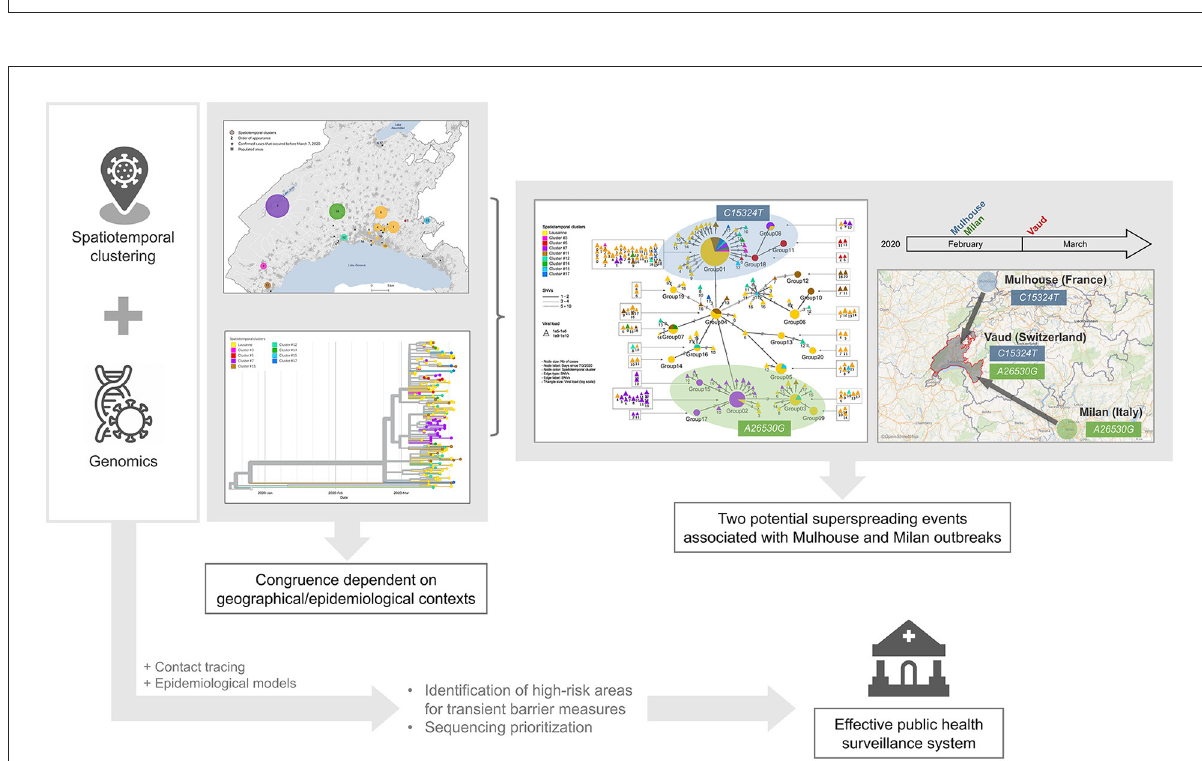
FIGURE5 Distribution of genomic groups within clusters. The size of the circle is proportional to the number of cases.